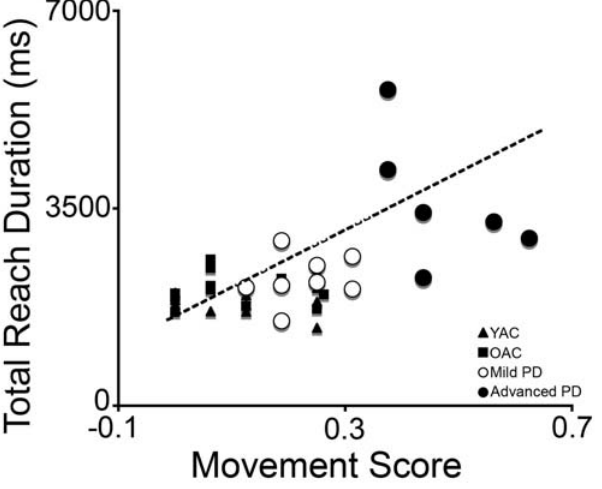
Figure 5. Correlation between movement score and total reach duration. The line represents the regression of the Parkinson’s diseased groups combined. Note the close relationship between the two